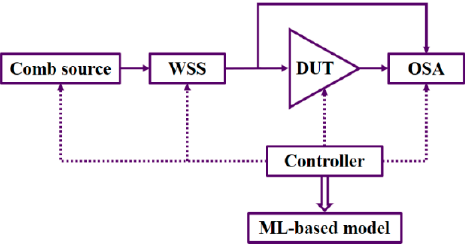
Figure 3. Experimental setup of EDFA data collection.